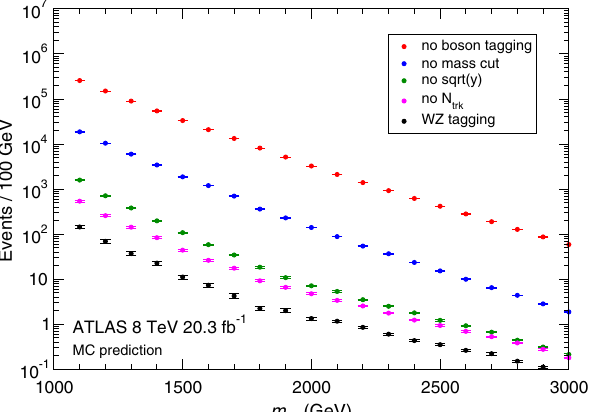
per jet. For the blue, green and pink lines two out of these three tagging criteria are applied. The red lines correspond to the prediction without any boson tagging. The error bars in the points represent the Monte √ y Carlo